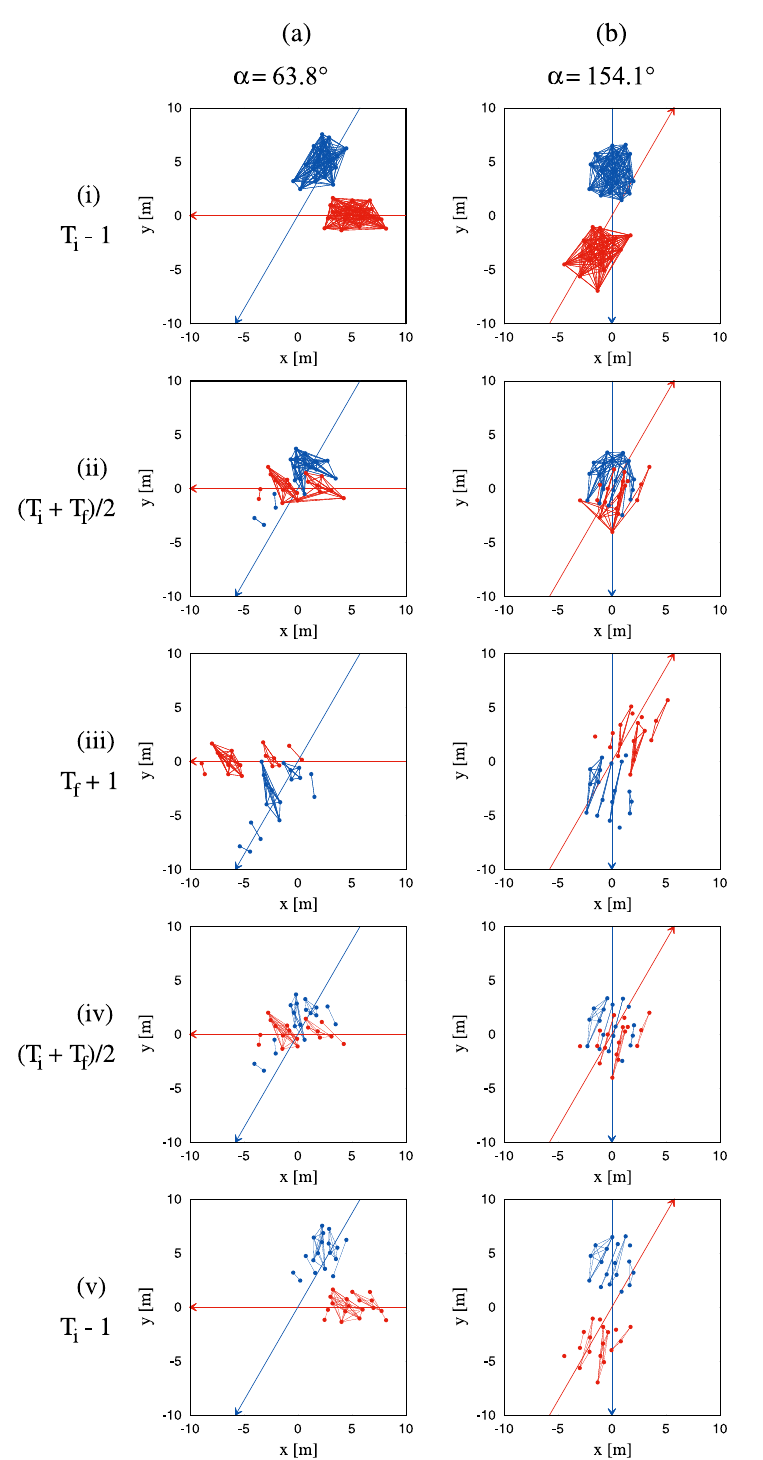
Fig 12. Examples of the edge-cutting process. Edge-cutting process for two trials with (a) α = 63.8˚ and (b) α = 154.1˚. The blue and red arrows denote the directions of motion for the two groups of pedestrians shown by blue and red dots respectively. The instances shown in this figure goes forward in time from (i) to (iii) and backward in time from (iii) to (v). In (i) the instance shown is T 1, when all the edges within a group are intact. (ii) Shows the situation when the i − edges have started to cut and stripes are gradually being formed at ( T i + T f )/2. (iii) Shows the situation at T f + 1 when all probable edge-cuts have taken place and the stripes have completely been formed. (iv) and (v) shows the instances as in (ii) and (i) respectively but with the visualisation of all the stripes that are completely formed only after T f .